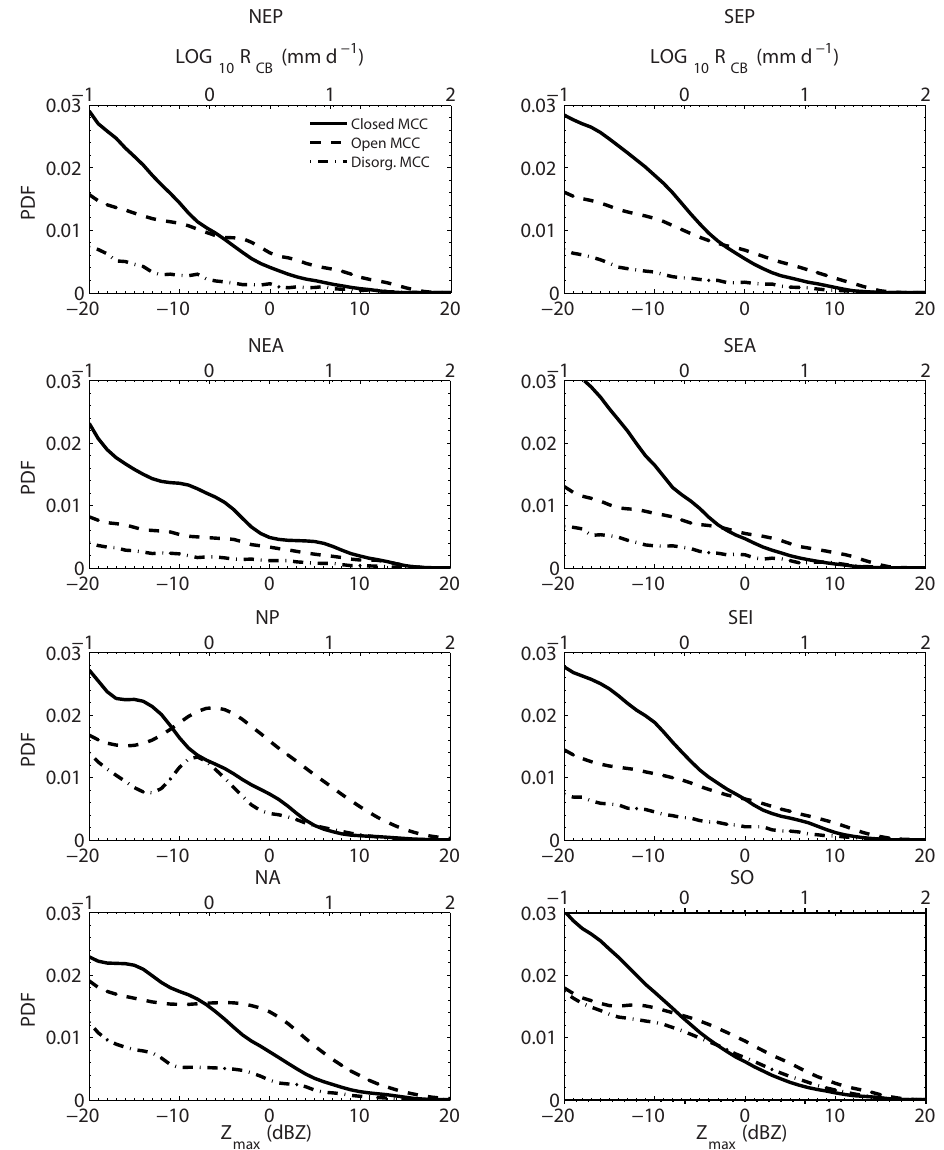
Figure 12. PDFs of column maximum radar reflectivity ( Z max ) for low clouds with closed (solid), open (dashed) and cellular but disorganized (dash-dotted) MCC types for the regions defined in Table